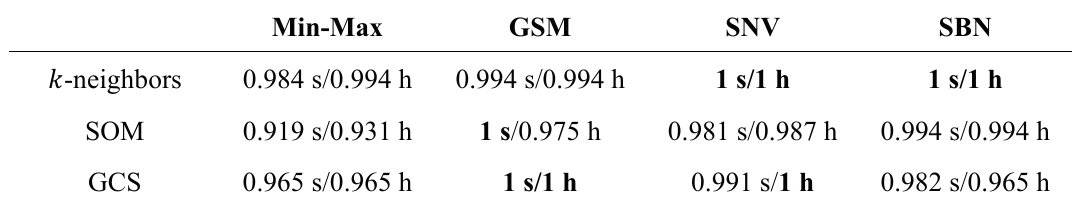
Table 6. Kappa indices obtained with the three classification techniques and the four normalization methods when denoising with the wavelet method (the letter denotes the use either soft or hard threshold).